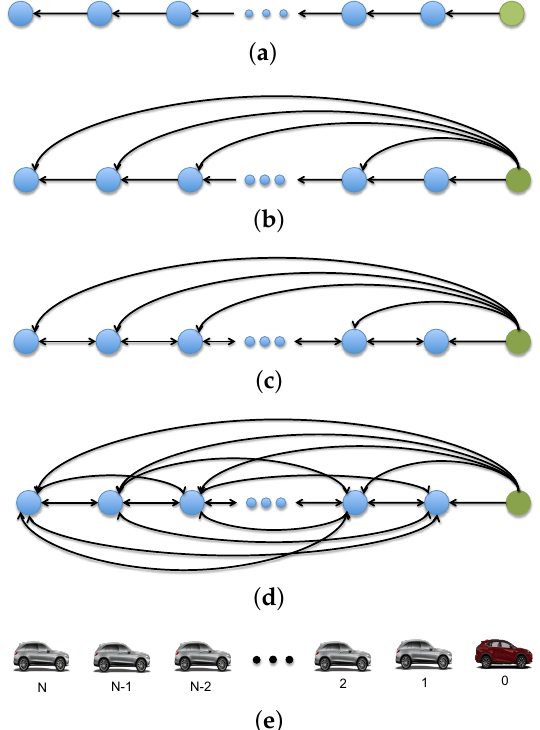
Figure 1. Exemplar communication topologies for a platoon of autonomous connected vehicles [13]: ( a ) predecessor–following (P-F), ( b ): leader–predecessor–following (L-P-F); ( c ): bidirectional–leader (B-D-L); ( d ): all-to-all (Broadcast, BR); and ( e ): platoon of N vehicles plus a